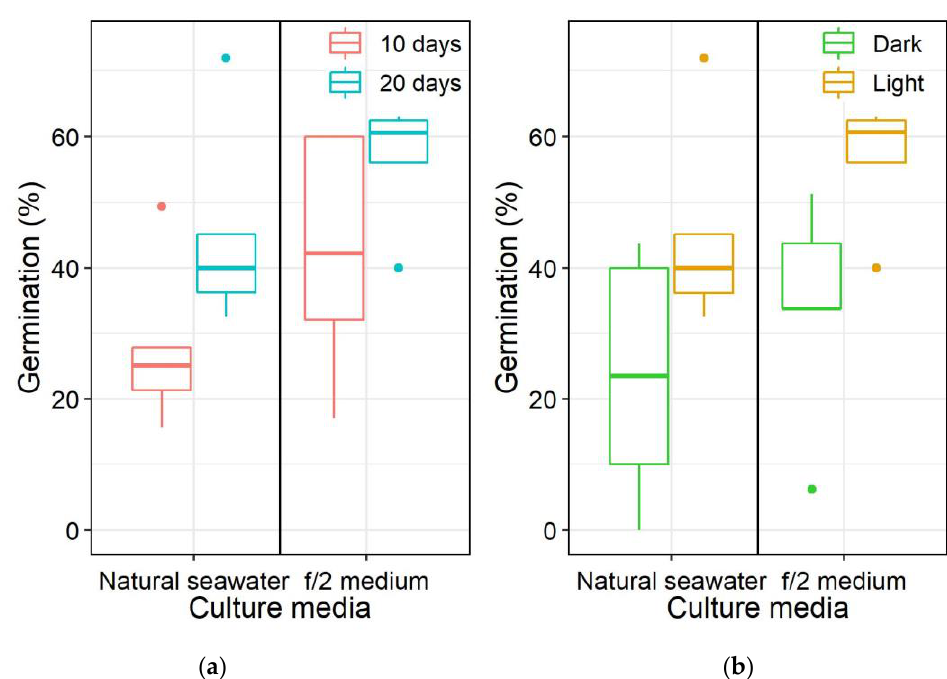
Figure 3. Germination of recent Pyrodinium bahamense cysts from San José Lagoon, SW Gulf of California: ( a ) in natural seawater and f/2 media for 10 and 20 days, and ( b ) under light and dark conditions for 20 days. Box plots show the median, lower (Q1) and upper (Q3) quartiles, and outliers (dots).